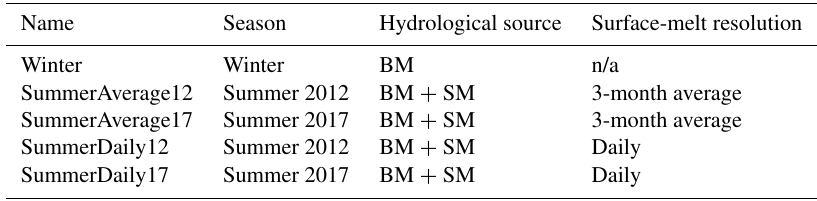
Table 2. Summary of hydrological simulations. BM: basal and internal melt; SM: surface melt.